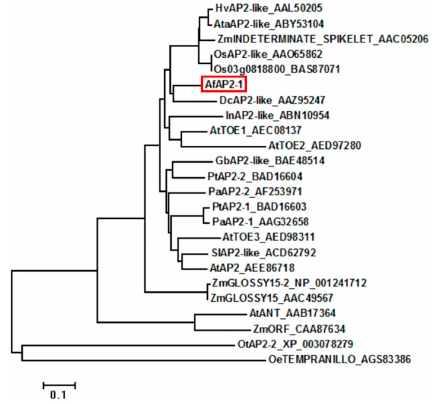
Figure 2. Phylogenetic analysis of AfAP2-1 and AP2 and AP2-like proteins from other plant species. The